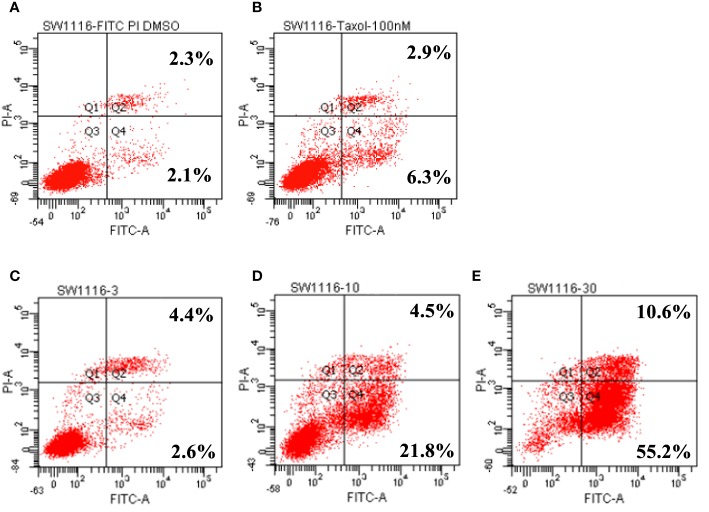
Leiocarpin E-7′-monoacetate induced early apoptosis. The annexin V fluorescein isothiocyanate (FITC)/propidium iodide (PI) staining assay was analyzed by flow cytometry. SW 1116 cells were cultured with chemicals for 36 h: (A) vehicle; (B) Taxol (100 nM); (C) leiocarpin E-7′-monoacetate (3 μM); (D) leiocarpin E-7′-monoacetate (10 μM); (E) leiocarpin E-7′-monoacetate (30 μM).